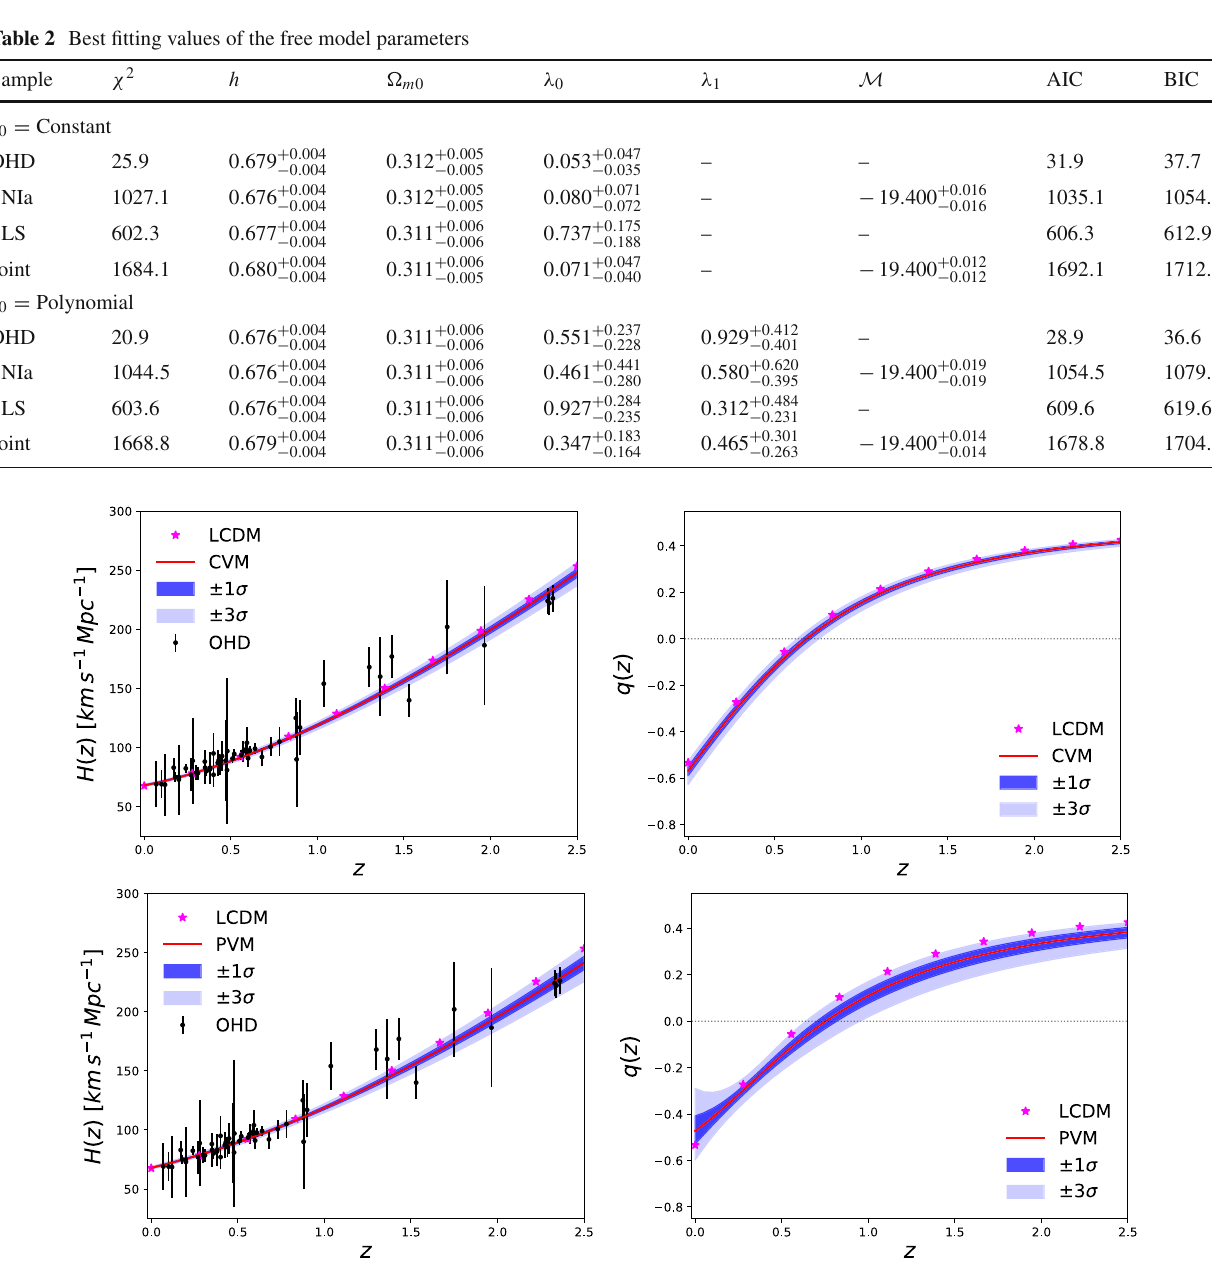
Fig. 2 Left panel: Best fits over OHD for the constant (polynomial) model at the top (bottom) panel. Right panel: deceleration parameter. The darker (lighter) bands correspond the uncertainty at 1 σ (3 σ ) CL. The (magenta) star marker represents the reconstruction of the LCDM model − 0 . 533 + 0 . 008 − 0 . 008 ). Furthermore, the values of q 0 are